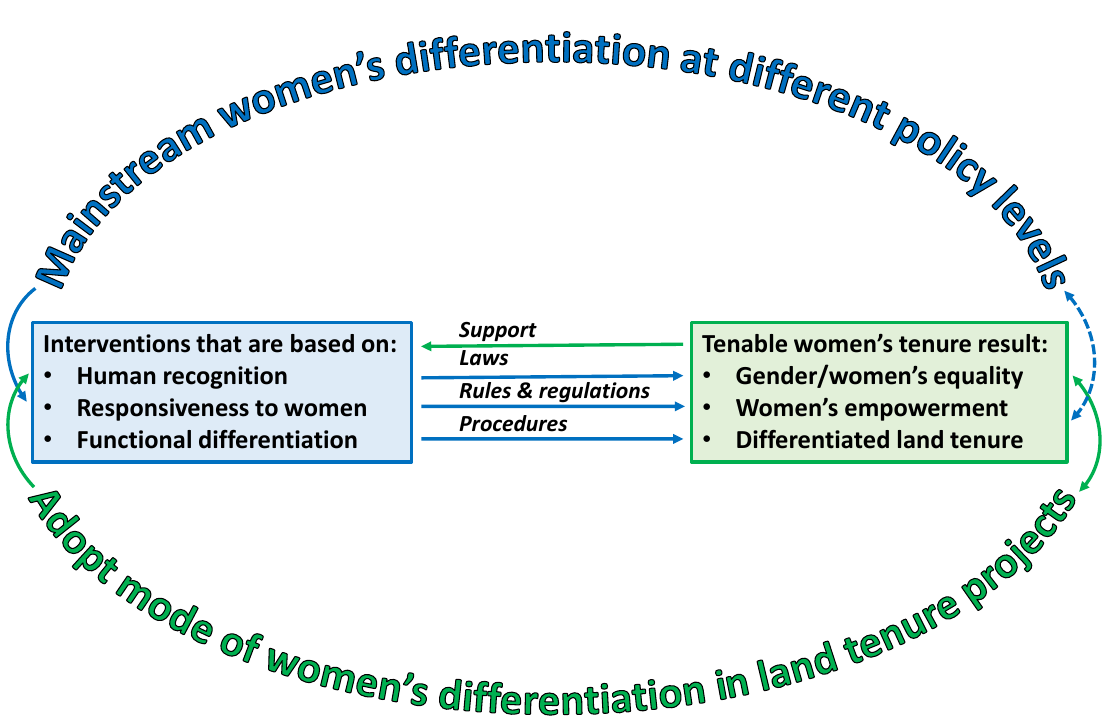
Figure 2. An adaptable approach for operationalising women’s differentiation in land tenure